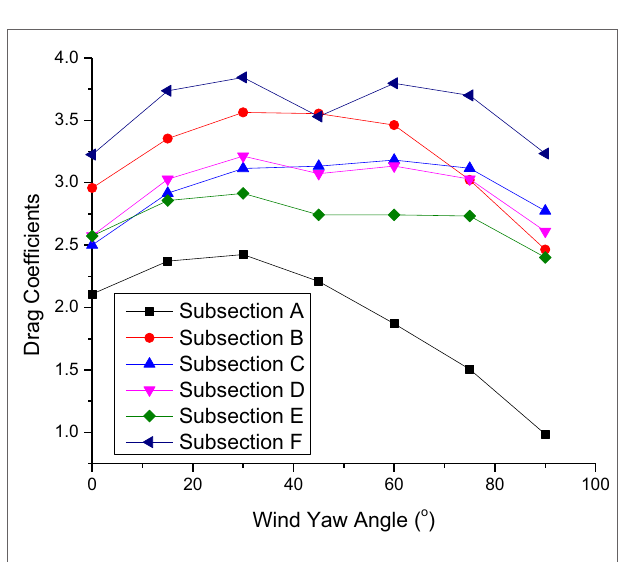
FigUre 7 | Definition of test yaw angle and body axes